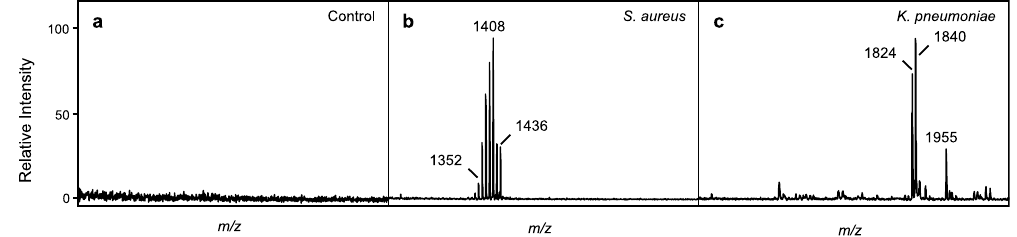
Figure 5. Detection of S . aureus and K . pneumoniae from blood culture. ( a ) Blood culture control containing sterile blood ( b ) Blood culture containing MRSA M2 after overnight growth (24 hours), and ( c ) Blood culture containing K . pneumoniae B6 after six hours growth. A 10 4 CFU inoculate was seeded into 10 mL blood, transferred to standard aerobic culture bottles and sampled at 1, 2, 4, 6, and 24 hours. Differential centrifugation allowed separation of human cells. Extraction and mass analysis was